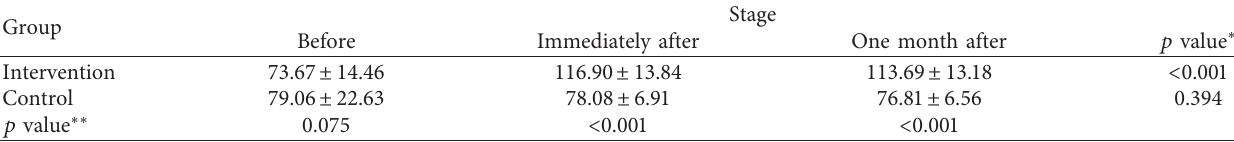
Table 1: A comparison between the mean scores of the control and intervention groups in compliance with nursing ethical codes as measured in three stages: before, immediately after, and one month after intervention.